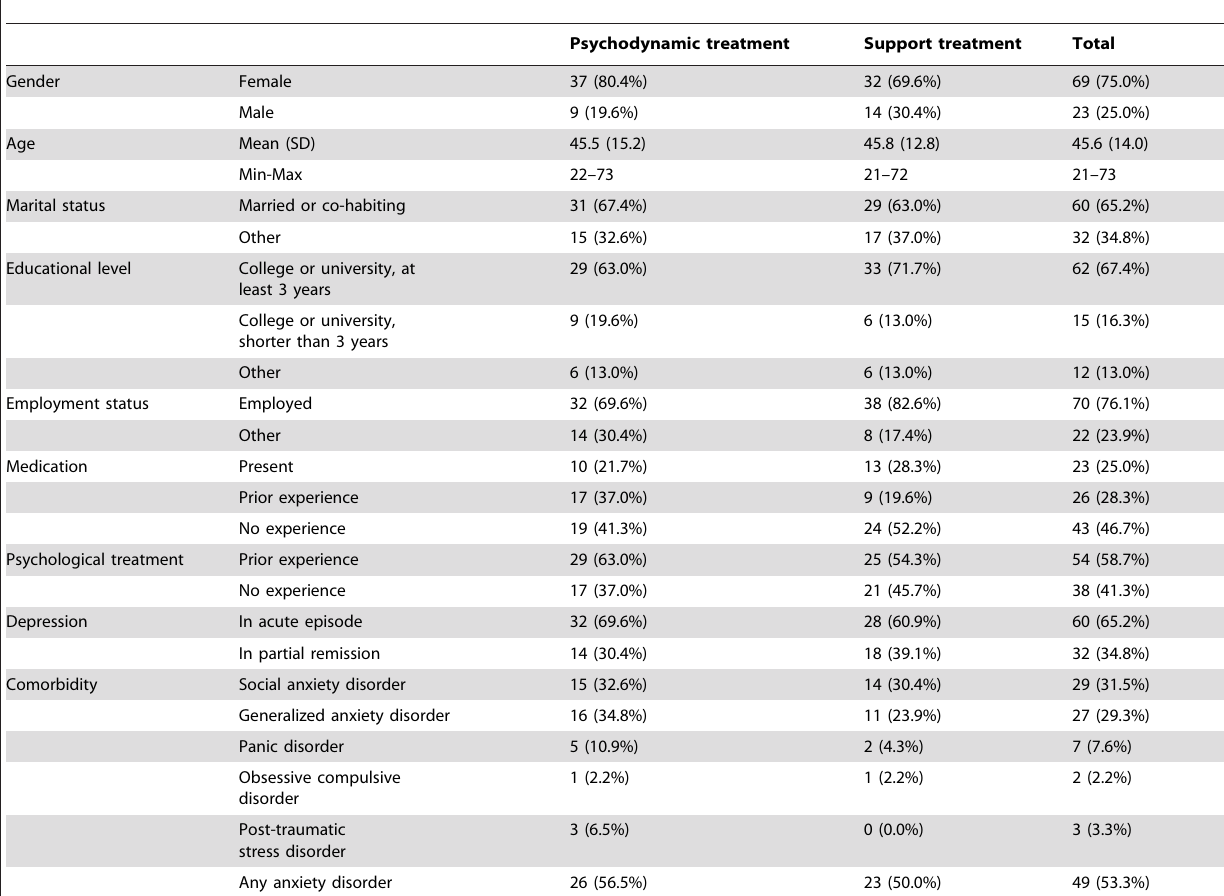
Table 1. Demographic description of the participants at